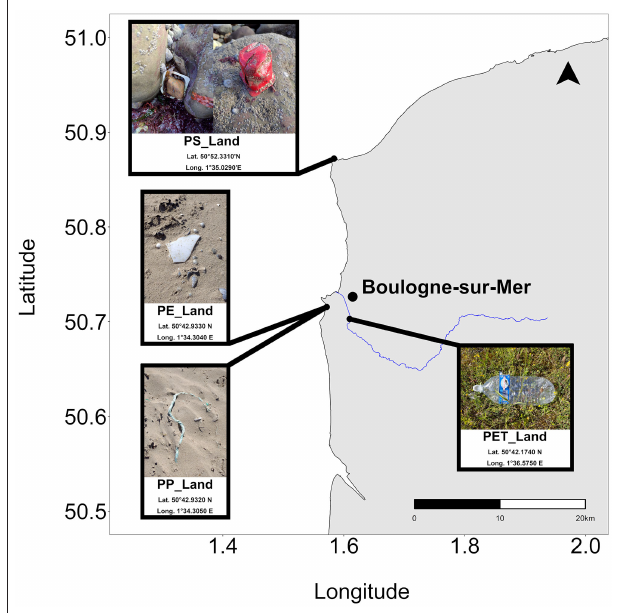
FIGURE 1 | Map with the locations of land-derived macroplastic collection. The scale bar illustrates a 20km distance and the black arrow points